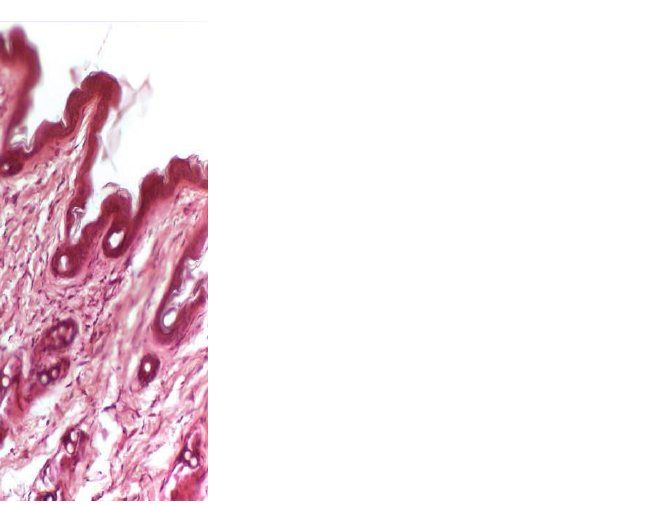
Figure 14. Tissue around Ti control sample (14 days), Hematoxylin eosin staining: tegument with thin epidermis, superficial and deep dermis, 10×.